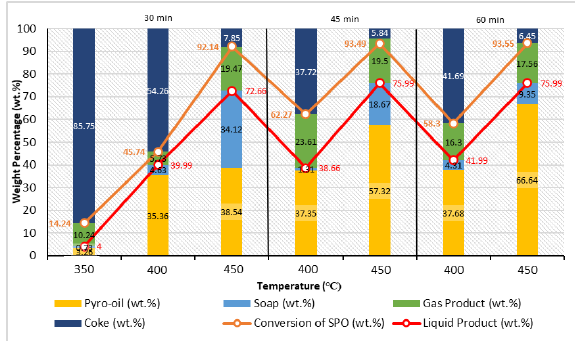
Fig. 2. Pyrolysis of SPO product distribution at various reaction times and temperatures (N 2 : 100 ml/min, 5wt.% Nickel dolomite catalyst: 150g SPO).